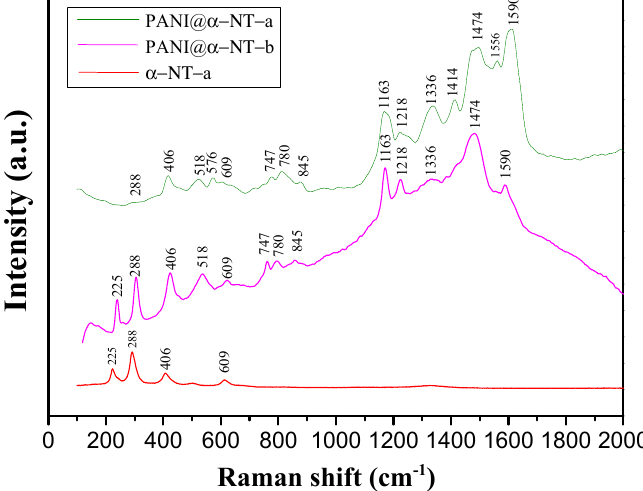
Figure 4. Raman spectra of PANI@ α -NT-a, PANI@ α -NT-b, and α -NT.